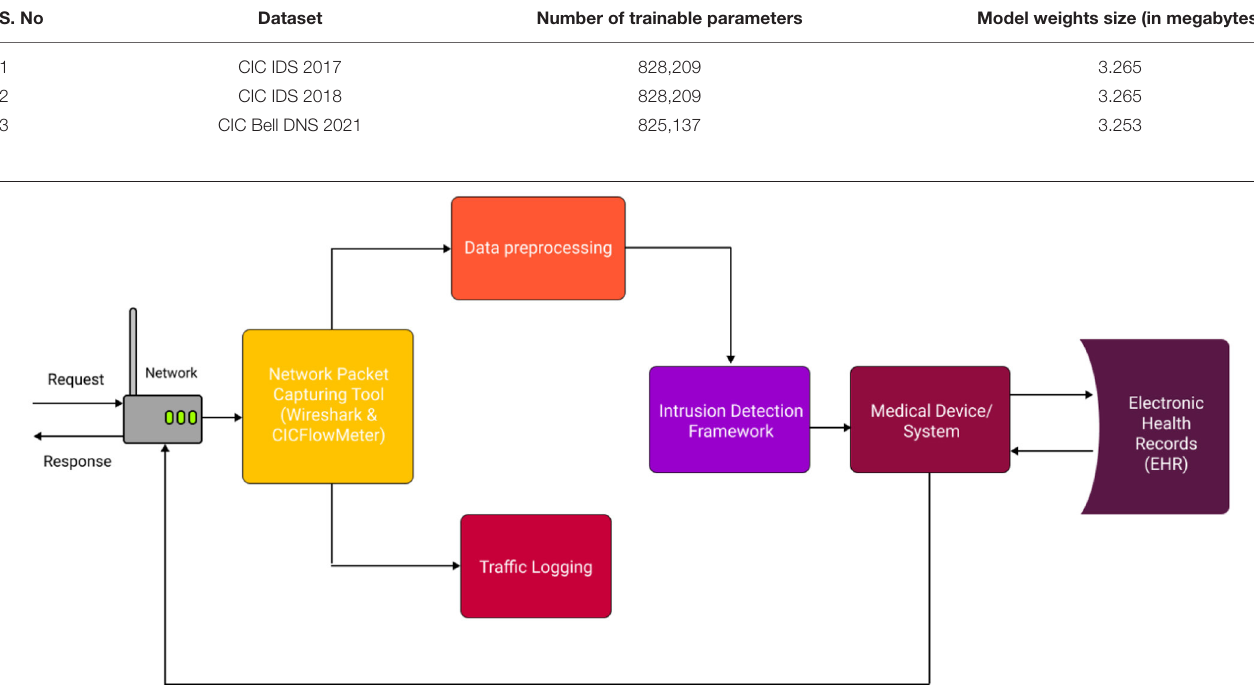
FIGURE 16 | System architecture diagram for the proposed intrusion detection